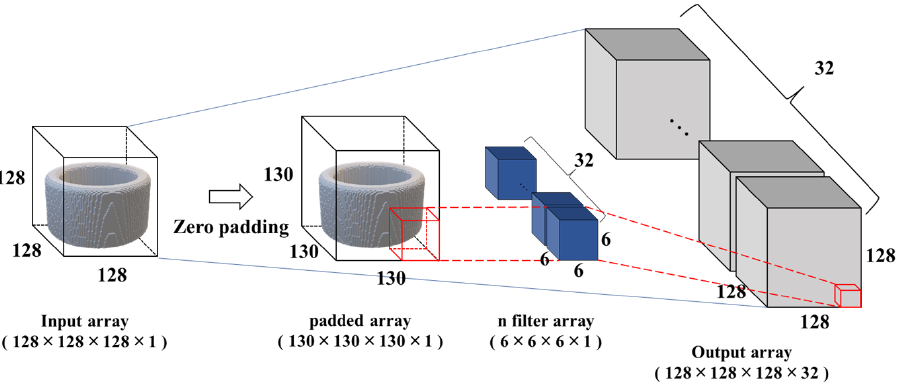
Figure 3. Procedure in the first convolutional layer.